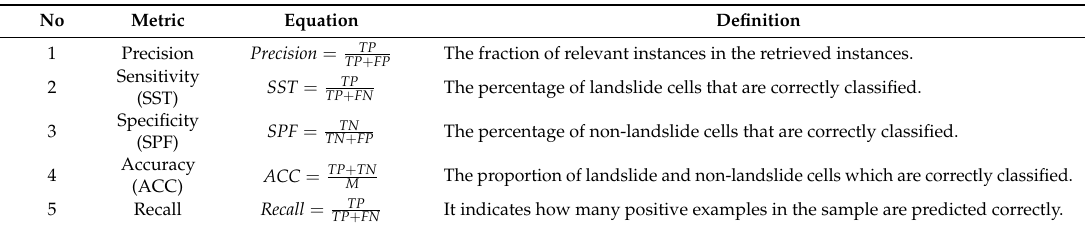
Table 3. Explanation of statistical-index-based